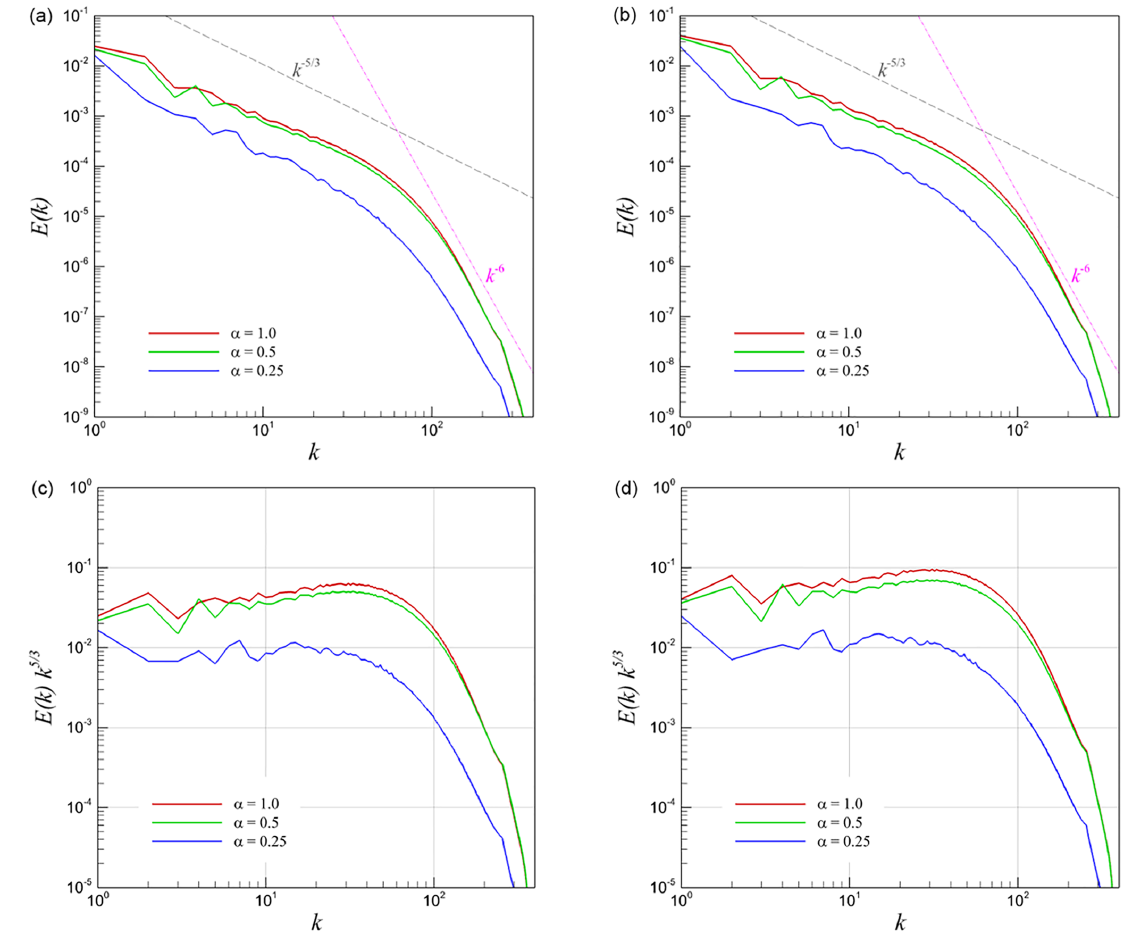
Figure 10. Spherical-averaged energy spectra for 3-D KHI turbulence. (a) Spectra built on using the velocity u , (b) spectra built on using √ ρ u , (c) compensated spectra built on using the velocity u , and (d) compensated spectra built on using the density-weighted velocity ω = √ ρ u the density-weighted velocity ω =